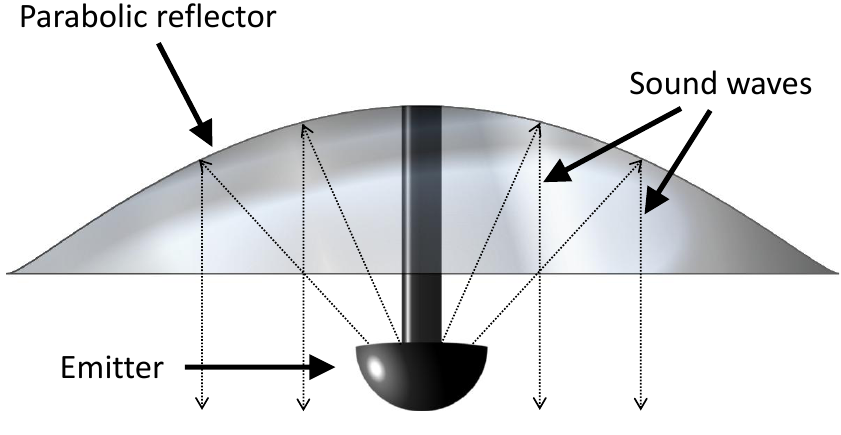
Figure 3. Conceptual drawing of a directional parabolic